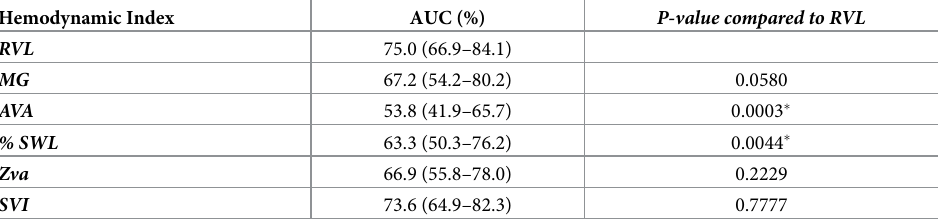
Table 5. Receiver operator curve analysis of the hemodynamic indices for predicting cardiovascular mortality 1-year post-TAVR. Hemodynamic